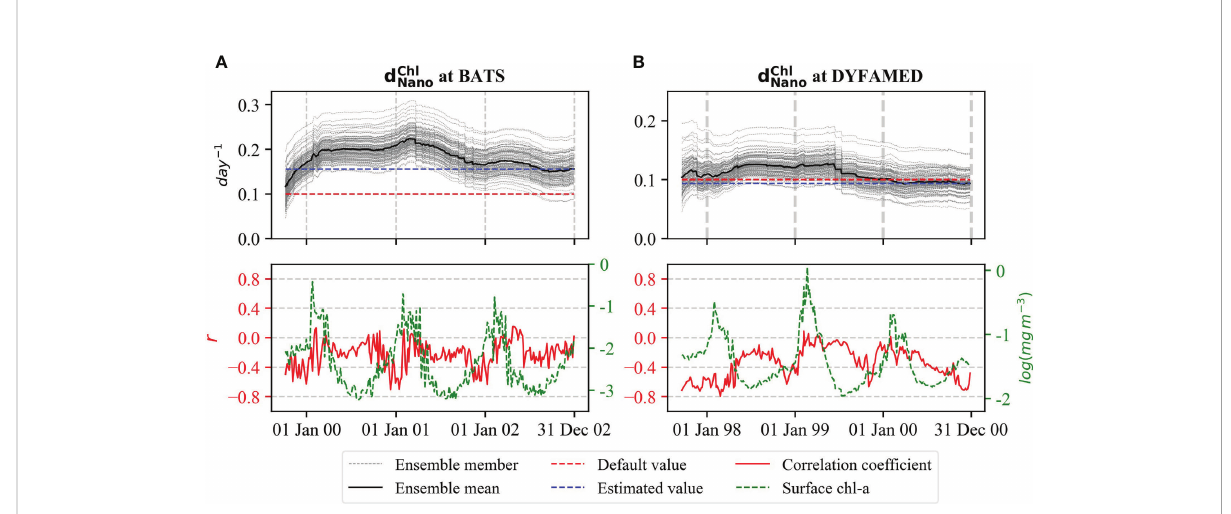
FIGURE 5 Evaluation of d Chl Nano rate for (A) BATS and (B) DYFAMED analogous to - Figure